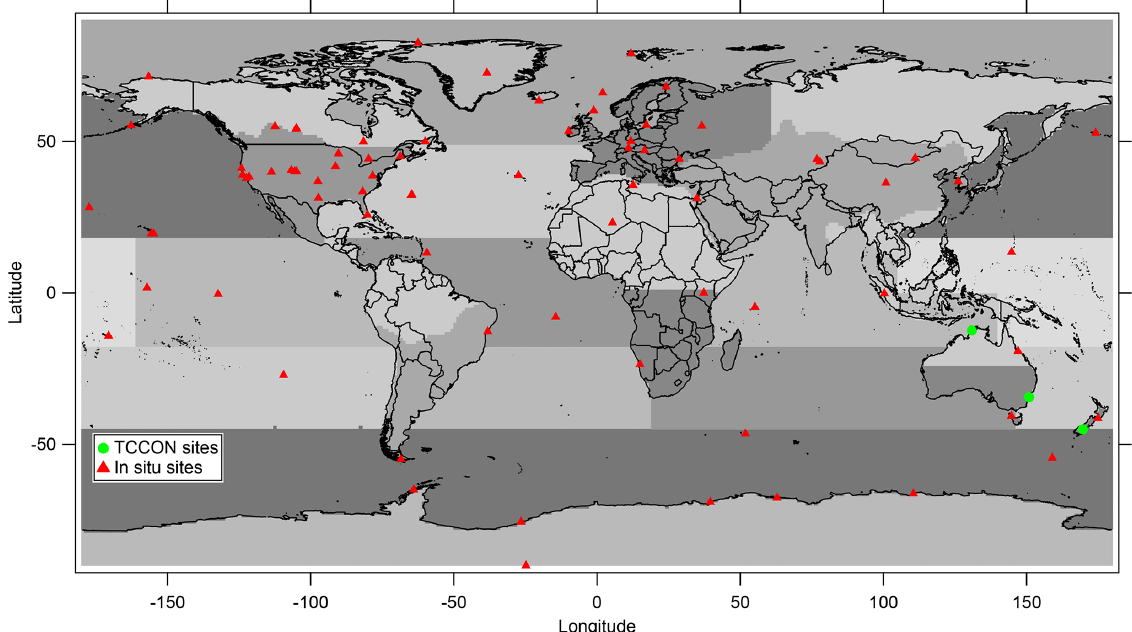
Figure 1. A world map showing the TCCON sites used in this study (green circles), other in situ sampling sites (red triangles) and the model aggregation regions used in this study, which are based on the TransCom